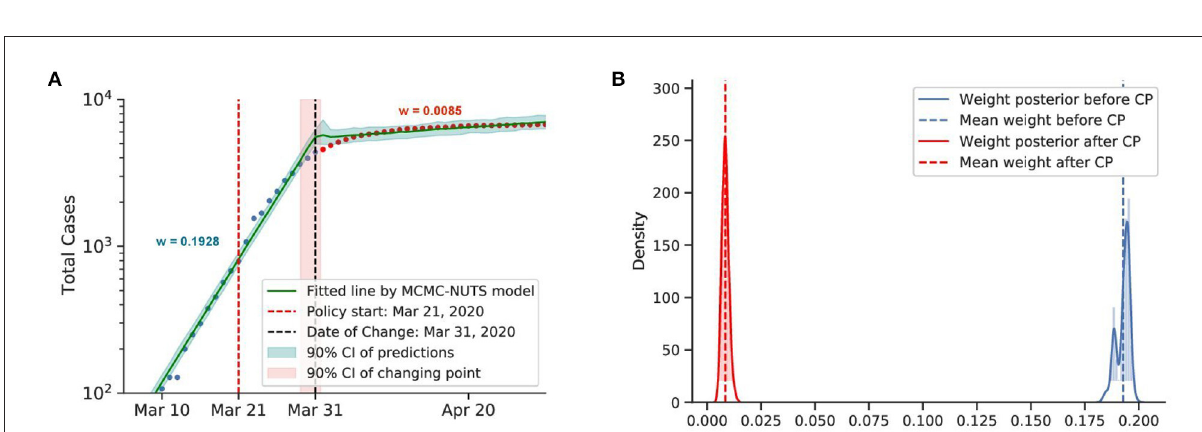
FIGURE9 Posterior for Australia. After confirming the first case, Australia recorded almost 10,000 cases before the end of March. With social distancing and contact tracing efforts from March 21, 2020 (74), Australia contained the spread, with a decline in the growth rate from 0.1928 to 0.0086. The change-point point was around March 31, 2020. (A) Fitted graph for Australia with change-point on March 31. (B) Posterior distribution of weights (transmission rate) before and after change-point.